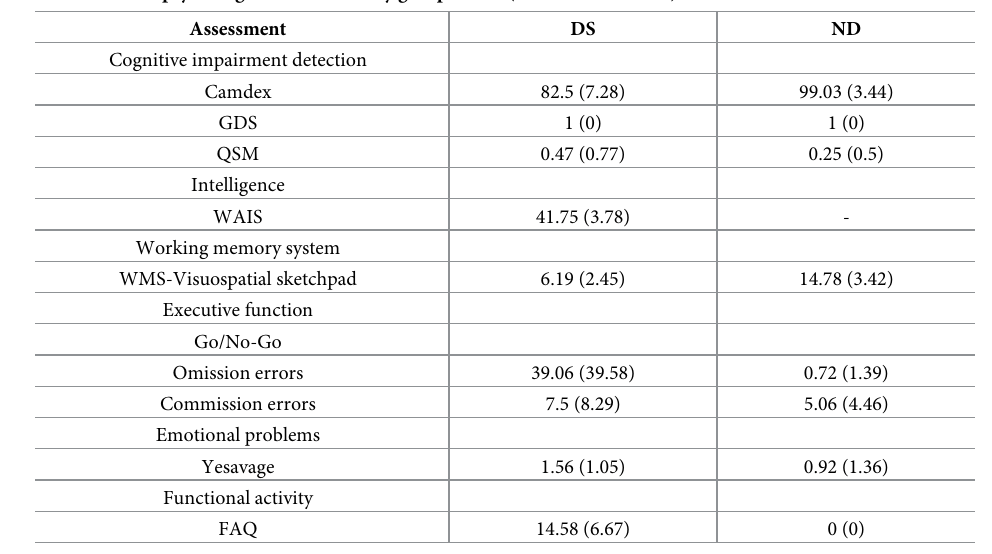
Table 1. Neuropsychological assessment by group: Mean (standard